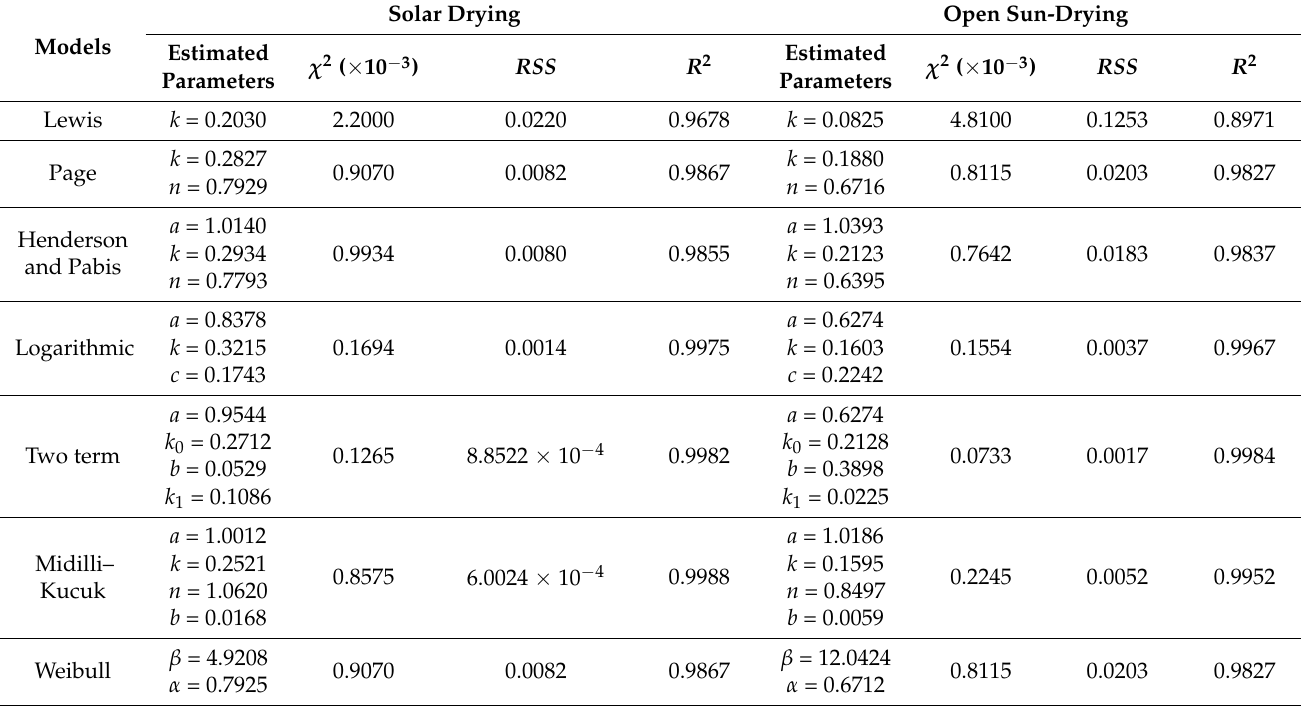
Table 5. Statistical results obtained from drying models in solar drying and open